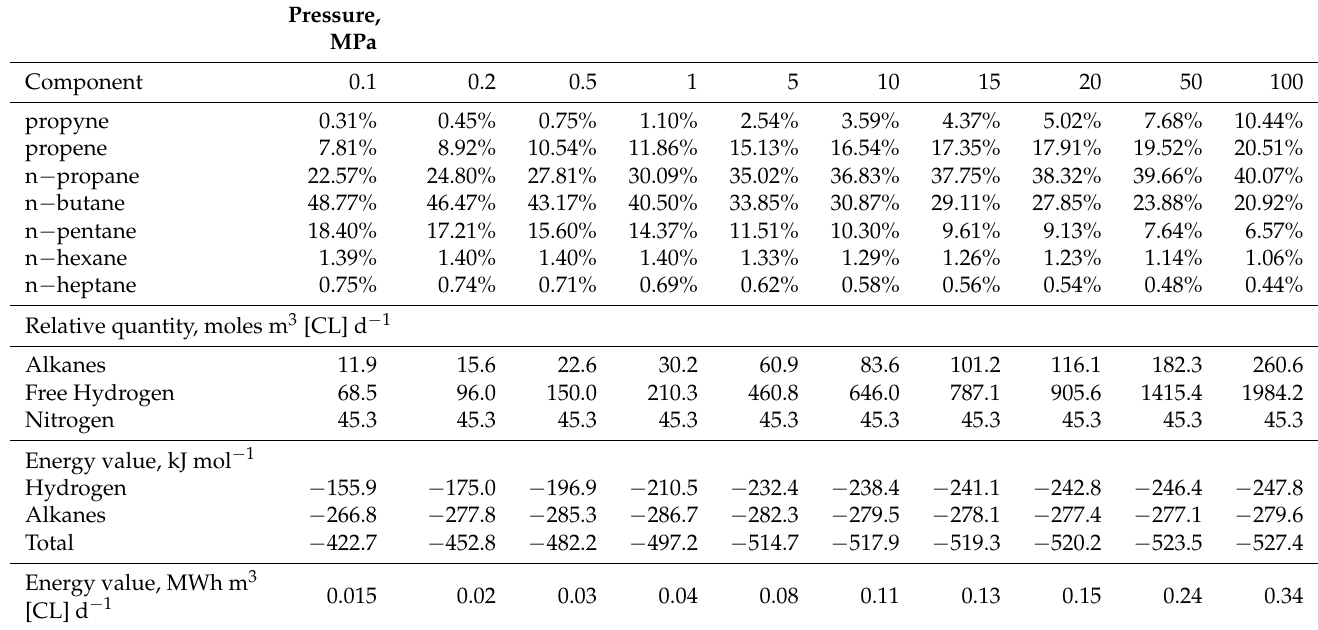
Table 18. Production of light hydrocarbons as a function of auto-pressurization of the reaction environment. Production volumes and energy values are standardized to a reactor train, retort size comprising 1 m 3 [CL] + 1.3 m 3 gas. T = <298K.